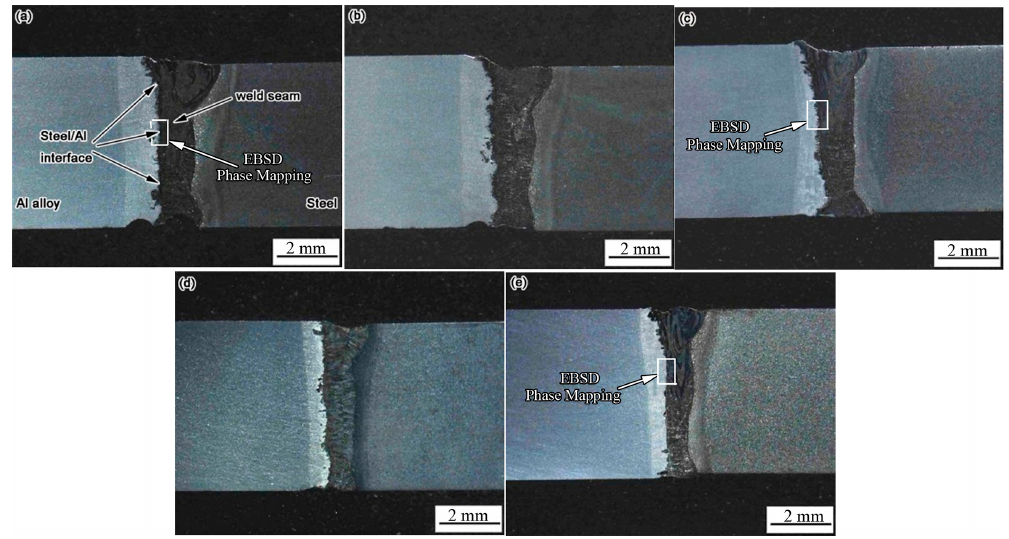
Figure 5. Effect of laser beam offsets on the cross-sections of Al/steel butt joints: ( a ) 0.3 mm; ( b ) 0.4 mm; ( c ) 0.5 mm; ( d ) 0.6 mm; ( e ) 0.7 mm.